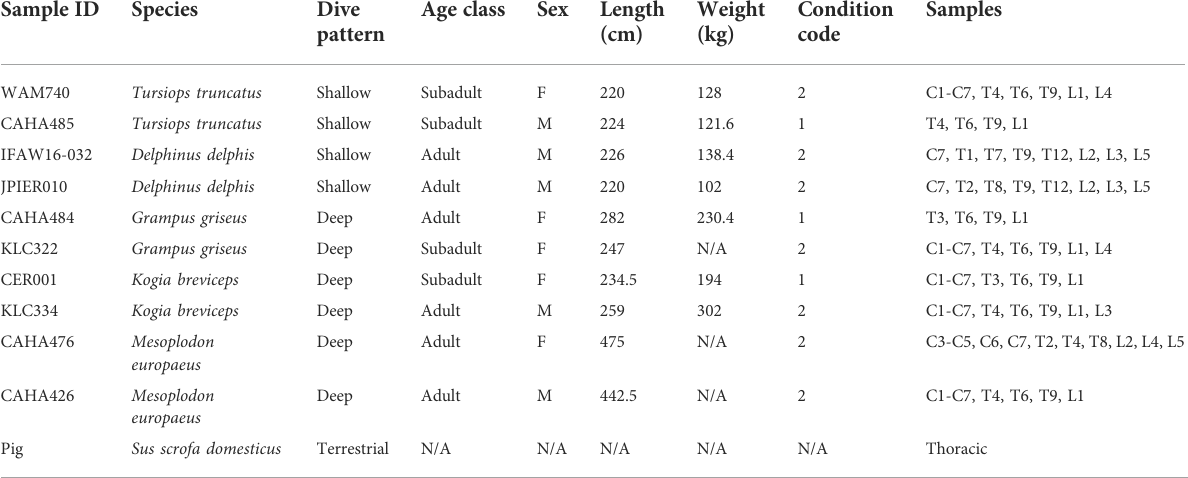
TABLE 1 Spinal cord samples analyzed in this study. Condition code: 1 — alive, 2 — fresh dead. C — cervical, T — thoracic, L — lumbar. Sample